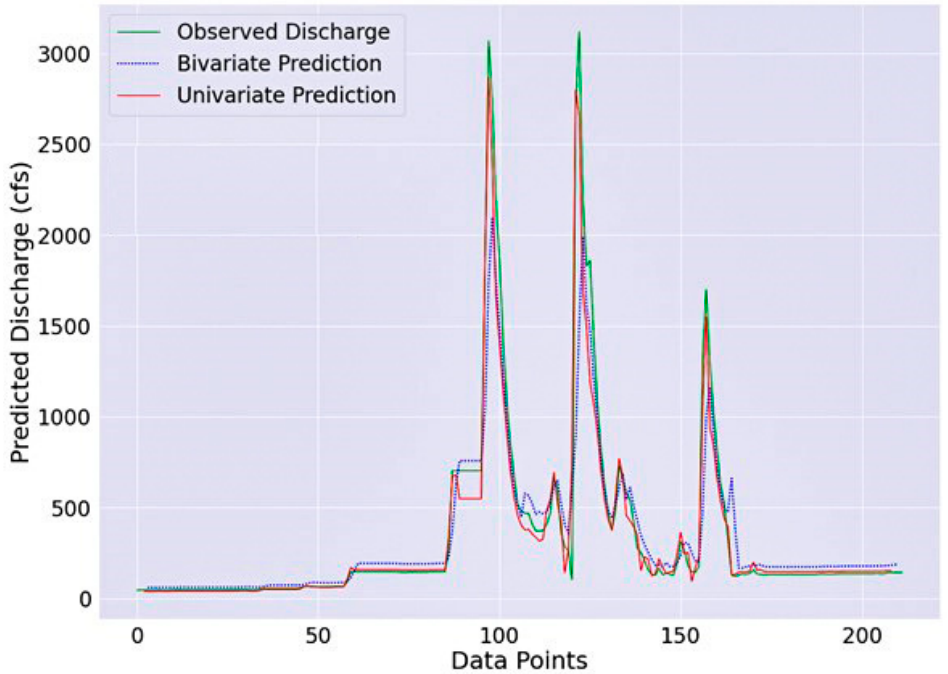
Figure 9. Univariate (discharge) with RMSE 151.52 ft 3 /s, bivariate (precipitation and discharge) prediction with RMSE 389.77 ft 3 /s, along with the observed discharge values for the year 2017. Model performance scores are mentioned in RMSE values for 30 days lag time and 1 day lead time.